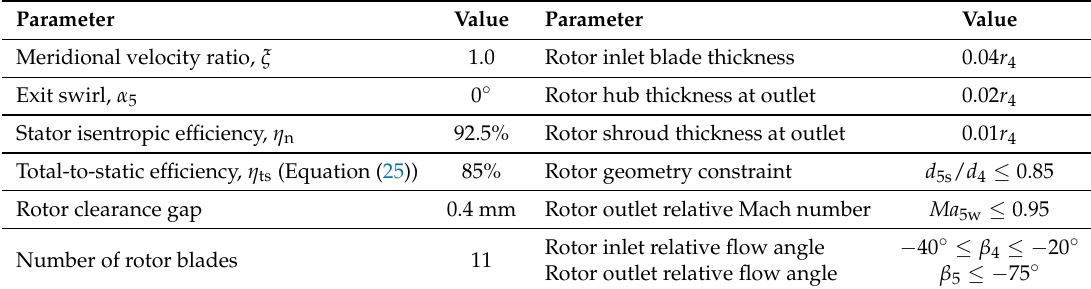
Table 5. Constraints and fixed parameters for the turbine optimisation